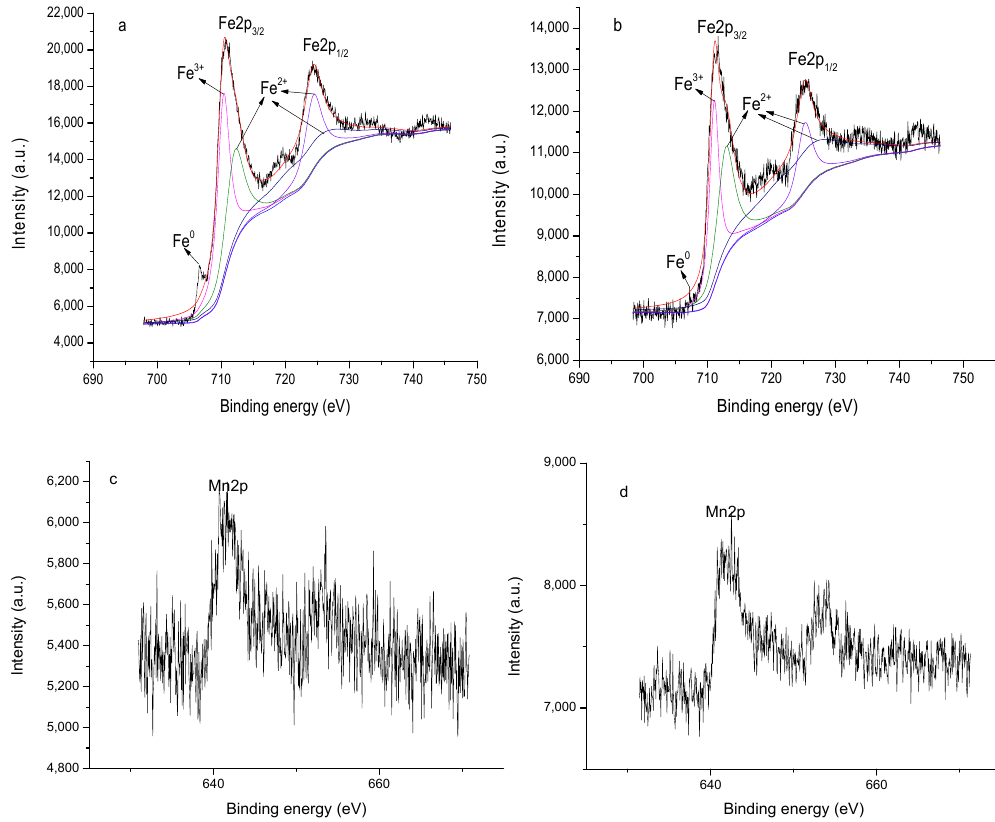
Figure 9. XPS analyses of high resolution spectra of Fe2p for Fe–Mn nanoparticles (NPs) ( a ) and Mn- doped Fe/rGO composites ( b ), Mn2p for Fe–Mn NPs ( c ) and Mn-doped Fe/rGO composites ( d ).